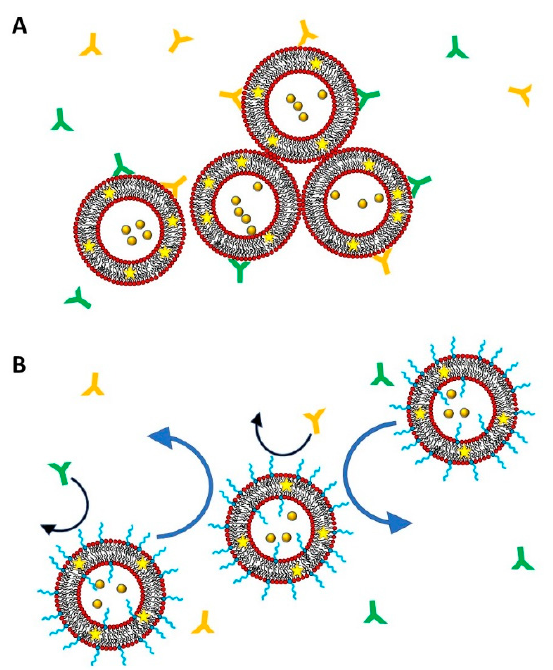
Figure 2. Scheme representing the mechanism for increased circulation time of PEG-decorated liposomes. ( A ) Conventional liposomes, bearing hydrophilic (orange balls) and hydrophobic (yellow stars) loads, aggregated and attacked by plasma proteins (Y-shaped antibodies in yellow and green); ( B ) stealth liposomes with PEG functionalization (cyan “hairs”) whose surface cannot be reached by plasma proteins.